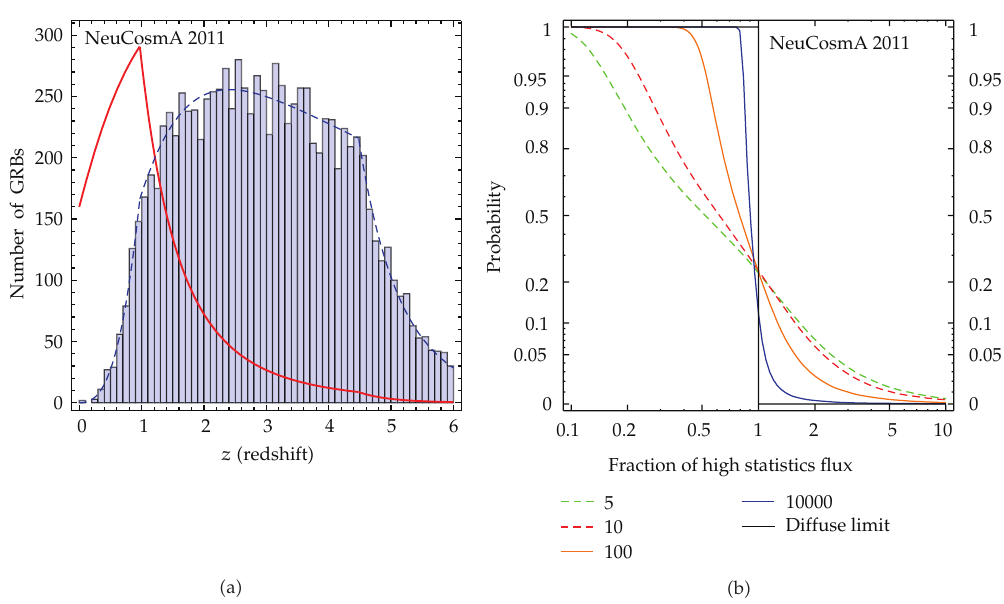
Figure 12: (cid:3) a (cid:4) Distribution of 10000 bursts d ˙ N/dz as a function of redshift (cid:3) histograms (cid:4) and relative contribution of the individual GRBs d − 2 L d ˙ N/dz (cid:3) solid curves (cid:4) . The dashed curve shows the exact distribution function. Here it is assumed that the GRBs follow the star formation rate from Hopkins and Beacom (cid:5) 117 (cid:6) with the correction E (cid:3) z (cid:4) from Kistler et al. (cid:5) 118 (cid:6) . (cid:3) b (cid:4) Probability that the quasi-di ff use flux extrapolated from a low statistics sample with n bursts is larger than a certain fraction of the di ff use limit (cid:3) see legend for di ff erent values of n (cid:4) . This function corresponds to (cid:3) one minus (cid:4) the cumulative distribution function of the probability density, figure taken from (cid:5) 30 (cid:6)